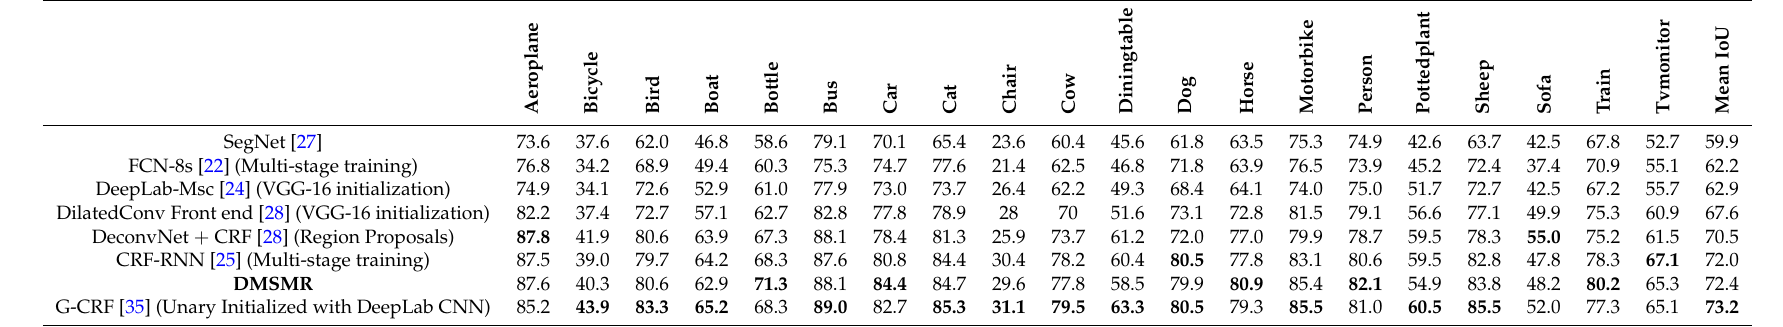
Table 2. PASCAL VOC12 dataset [72] results. We compare our proposed network with recent methods that support inference techniques. Additional aides, such as region proposal, multi-stage inference, and extra unary initialized model, are unnecessary in our approach. Some of the methods use the CRF as a post optimization procedure. In contrast, our proposed approach achieves competitive accuracy without post-processing in an end-to-end